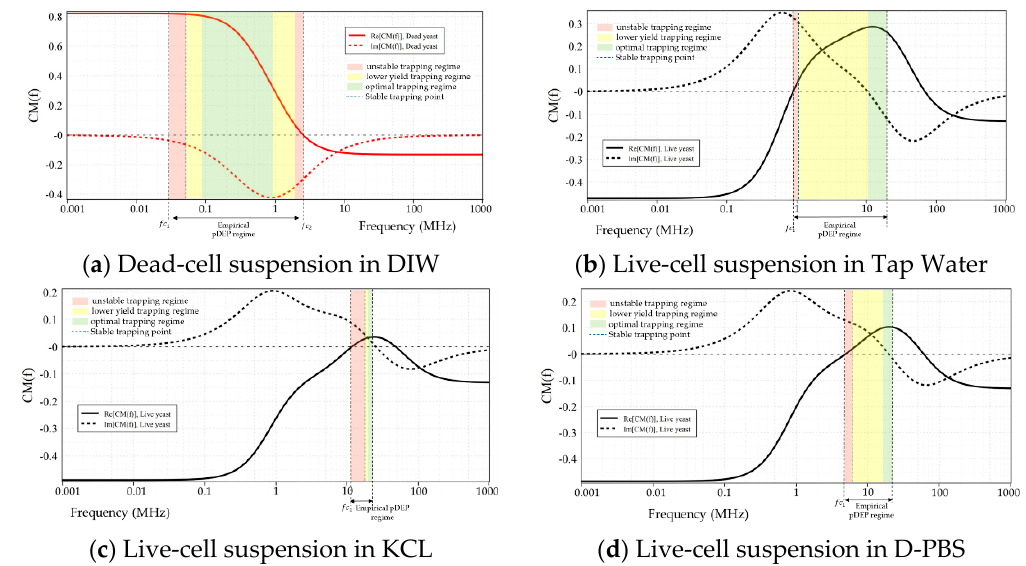
Figure 7. Empirically proven pDEP regime and crossover frequencies ( fc ) vs. numerical predictions for: ( a ) dead yeast suspension in DIW and live cell suspensions in; ( b ) Tap water; ( c ) KCL; ( d ) D-PBS. Colored frequency bands represent empirically proven trapping behavior based on optical observations.